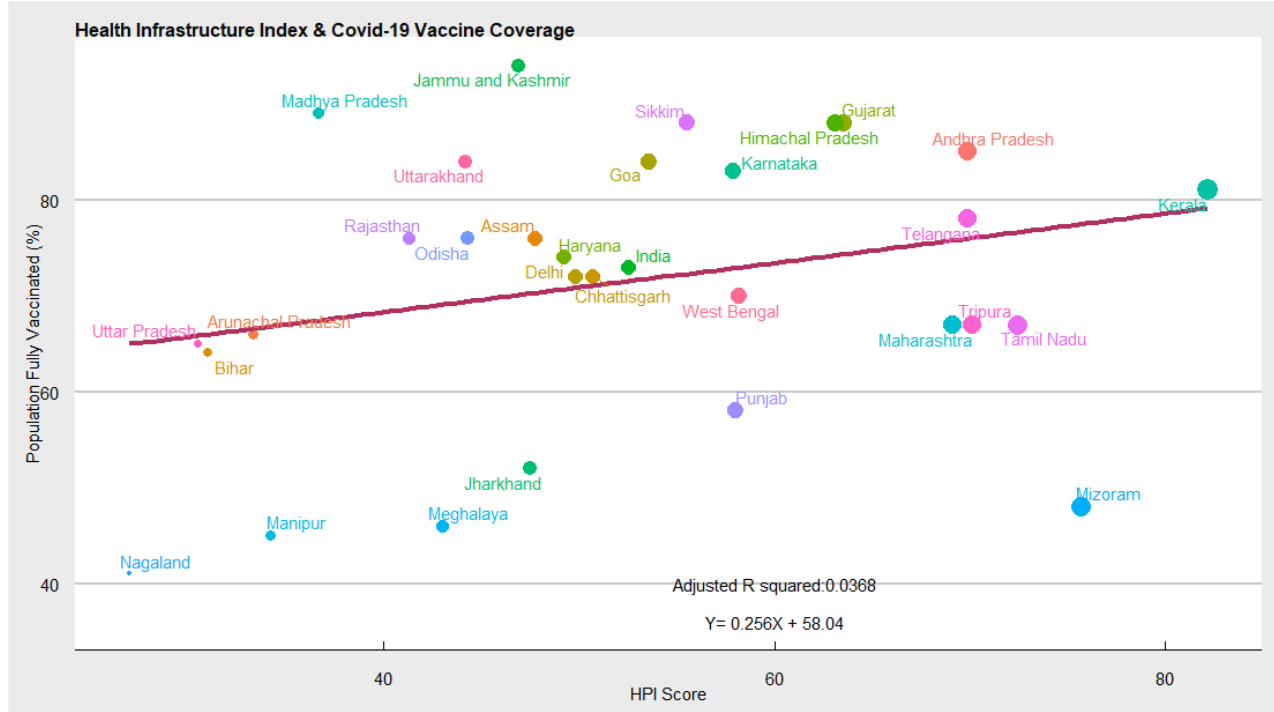
Figure 4. Scatter plot depicting state of health infrastructure and vaccination